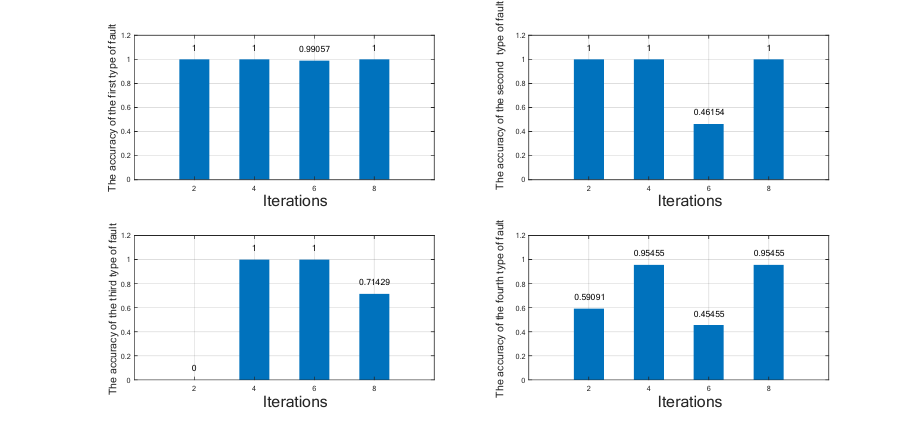
Figure 6. Diagnostic accuracy of various